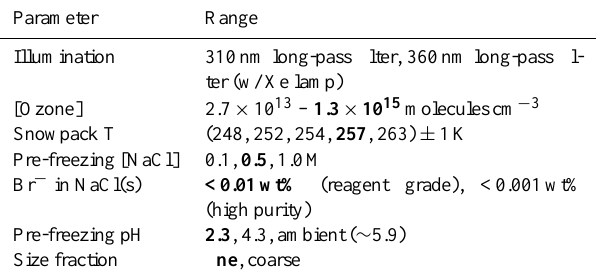
Table 1. Parameters used in the experiments. The BASE scenario conditions are shown in bold